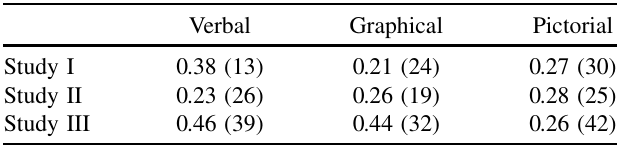
TABLE III. Distribution of answers using correct argument based on energy conservation.